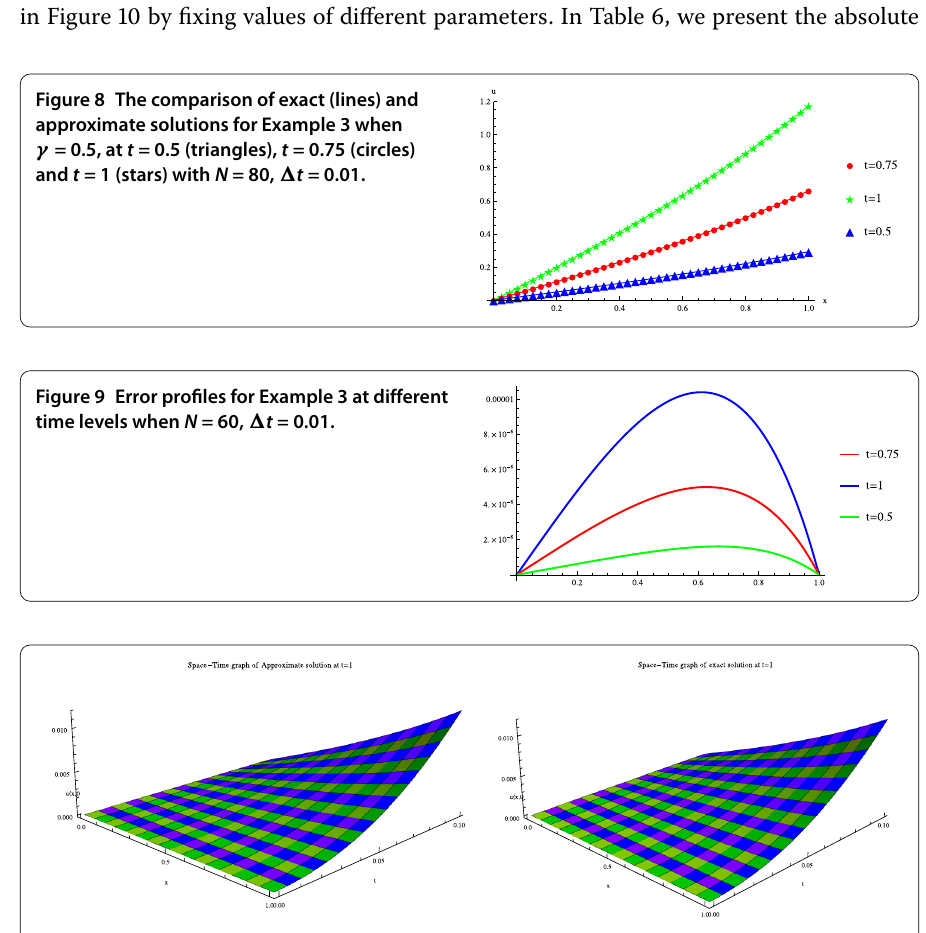
Figure 10 3D space-time graphs of exact and numerical solutions for Example